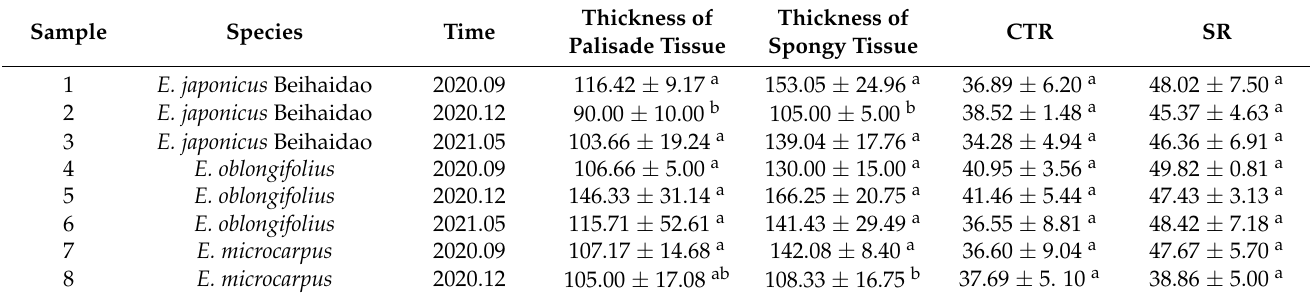
Table 3. Changes in leaf tissue structure compactness of three Euonymus